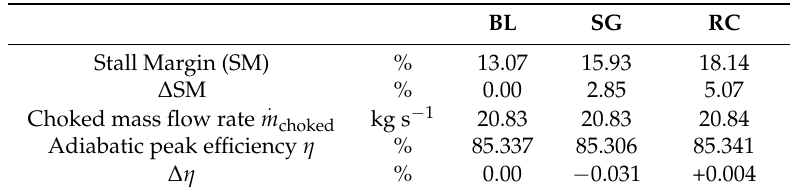
Table 3. Summary of the overall performance obtained by steady RANS simulations with and without the casing